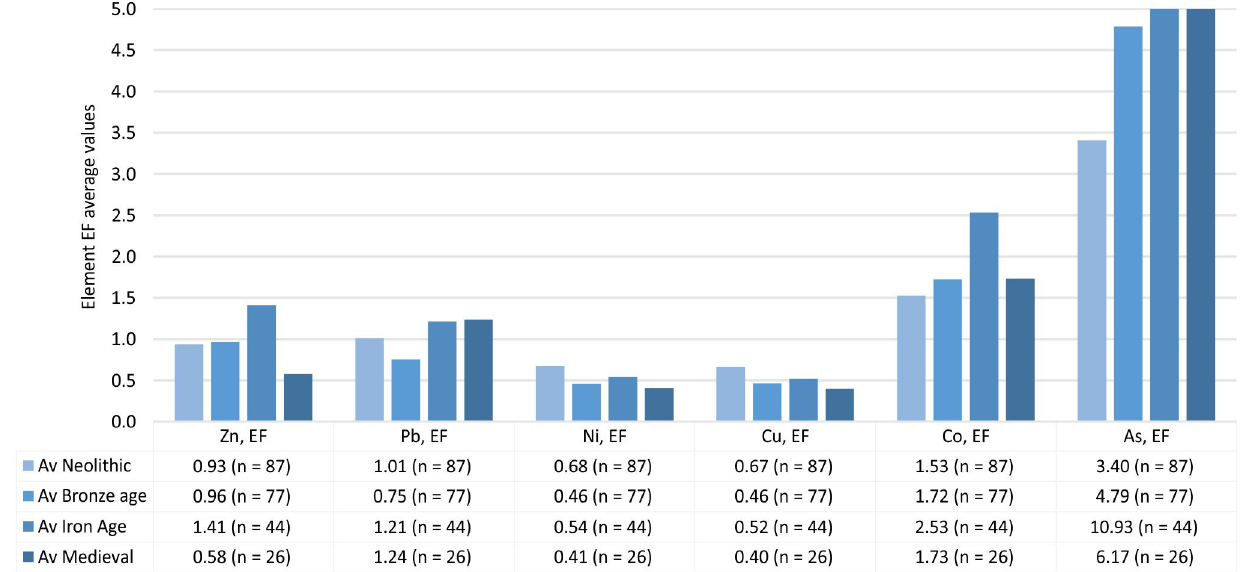
Figure 4. The average values of element enrichment factors (EF) in the Kamyshovoe Lake sediments according to historical period.